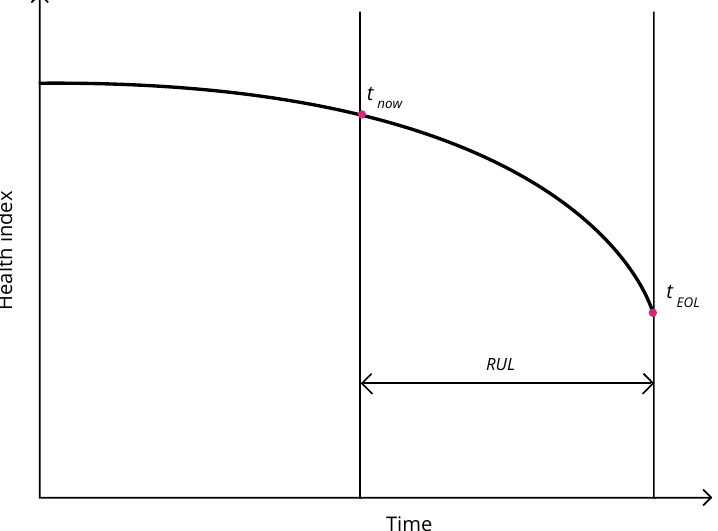
Figure 1. Remaining useful life illustration (adapted from [14])